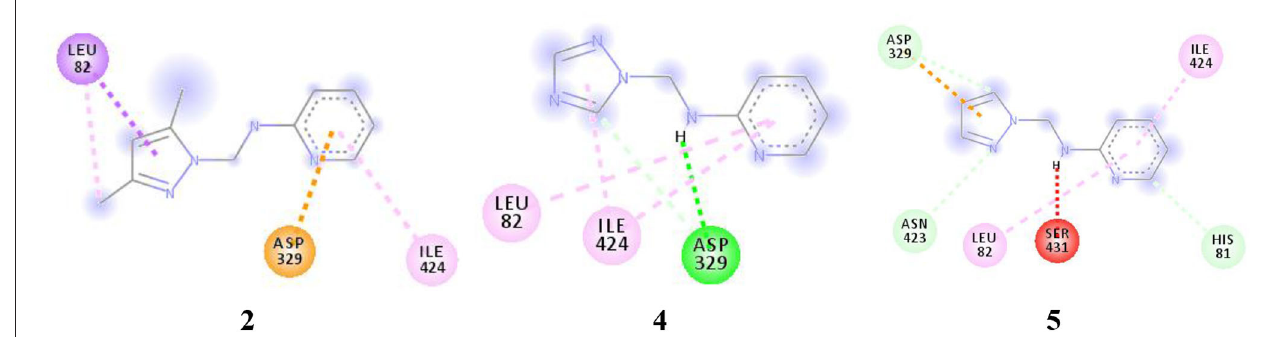
FIGURE 12 | The two-dimensional interactions of ligand 2, 4 , and 5 with the chosen active site in the Fophy protein.